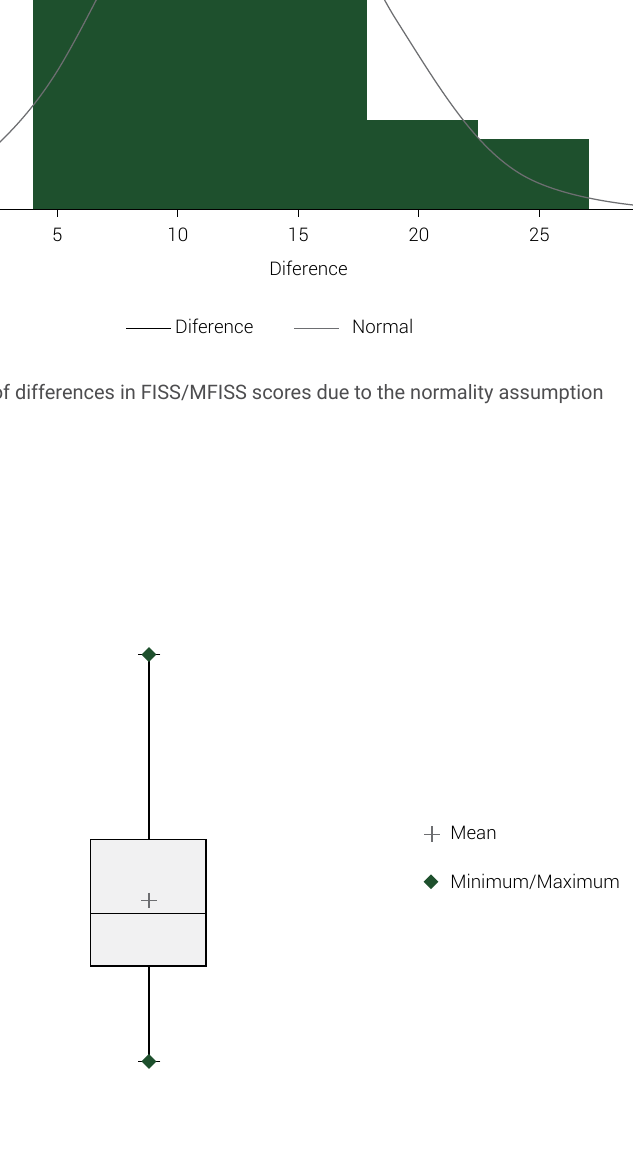
Figure 4. Correspondence between mean and median of FISS/MFISS due to the Bland-Altman analysis